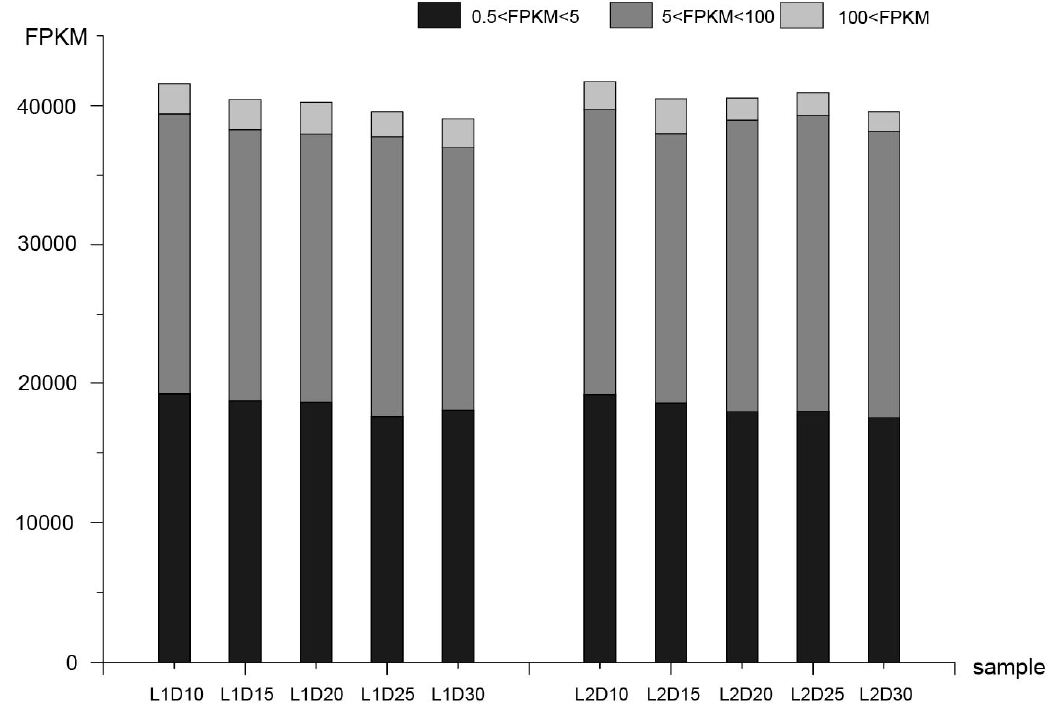
Figure 1. Statistics for transcript levels at each development stage, the numbers of genes and classification were divided by 0.5 < FPKM < 5, 5 < FPKM < 100, and 100 < FPKM in each sample. FPKM: fragments per kilobase of exon per million reads